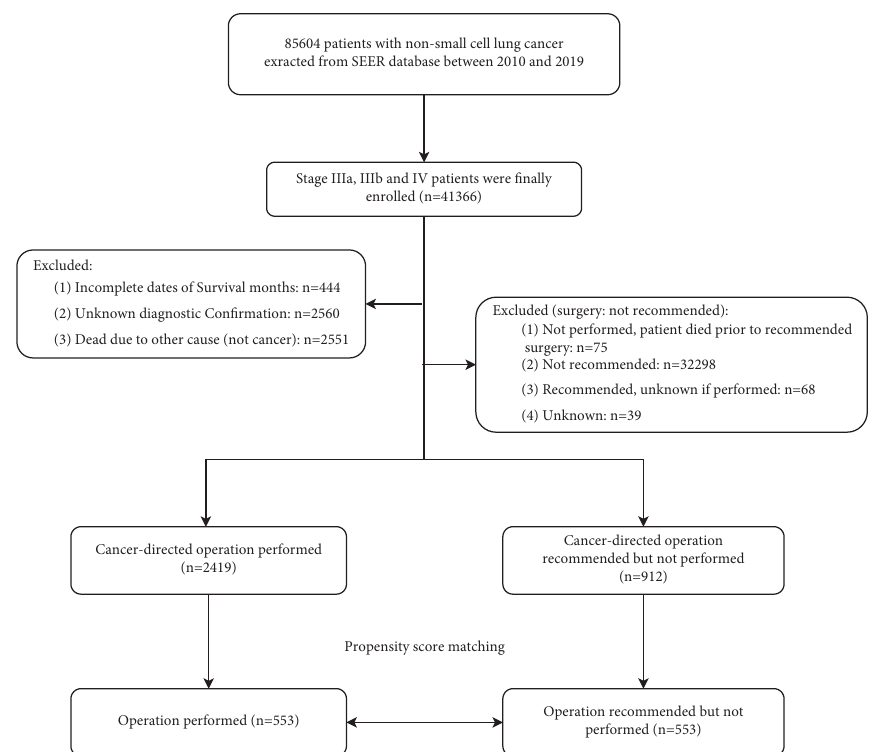
Figure 1: Te fow chart of the